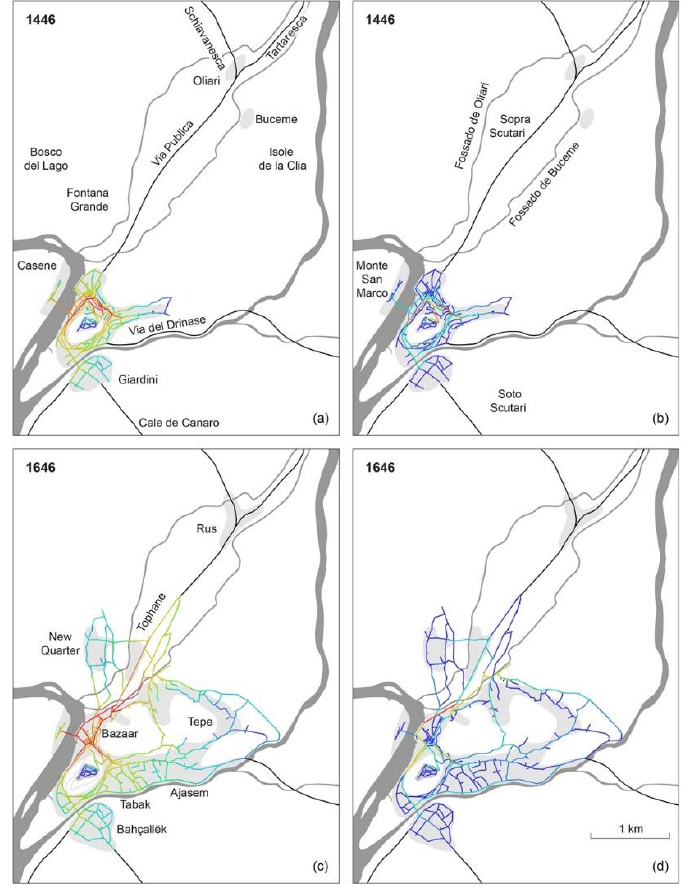
Figure 2 Axial map of Shkodër’s street network during the Venetian period (1446) and early Ottoman period (1646) colored according to values of integration (a, c) and choice (b,